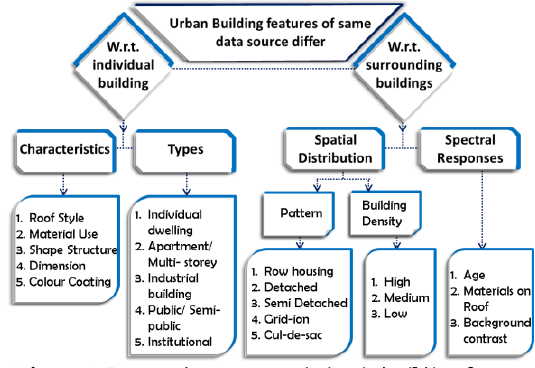
Figure 1. Factors that cause variation in building features within the same